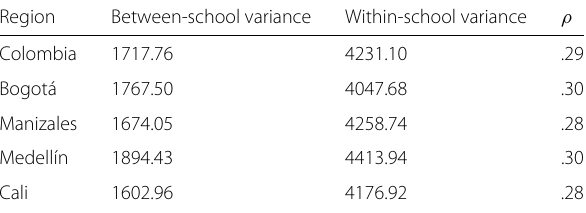
intraclass correlation ( ρ ) Region Between-school variance Within-school